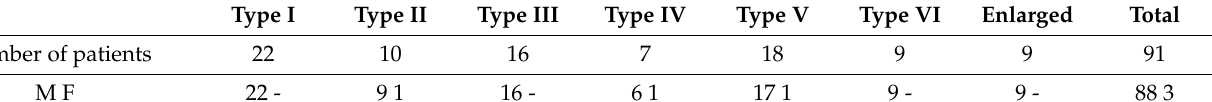
Table 2. Type of operation, histologic results and treatment modalities.